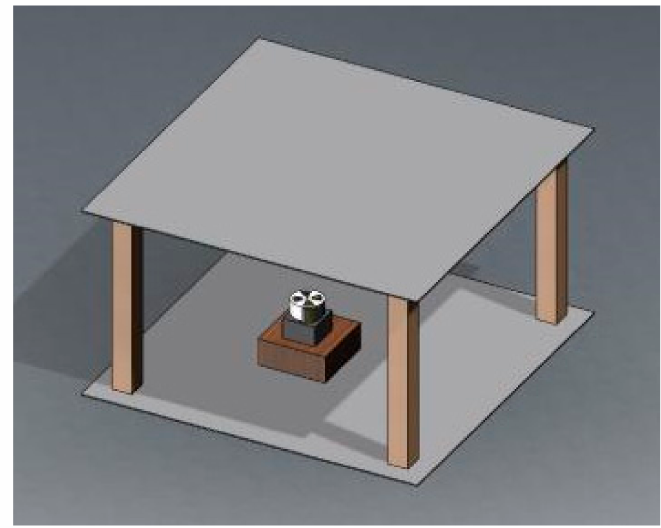
Figure 5. Calibration device model of three-dimensional electric field sensor.